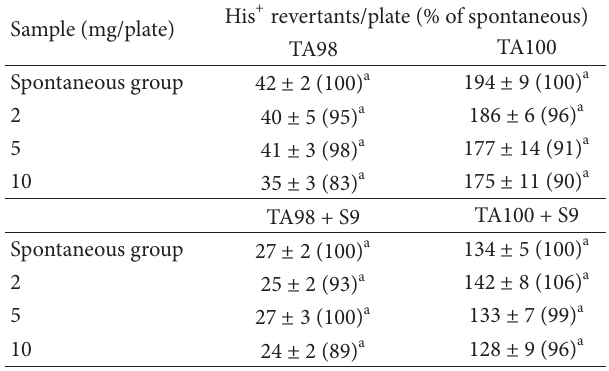
GTE on 2-AA induced mutation in S. typhimurium TA 98 and TA 100, with S9 activation. GTE at levels of 2–10 mg/plate